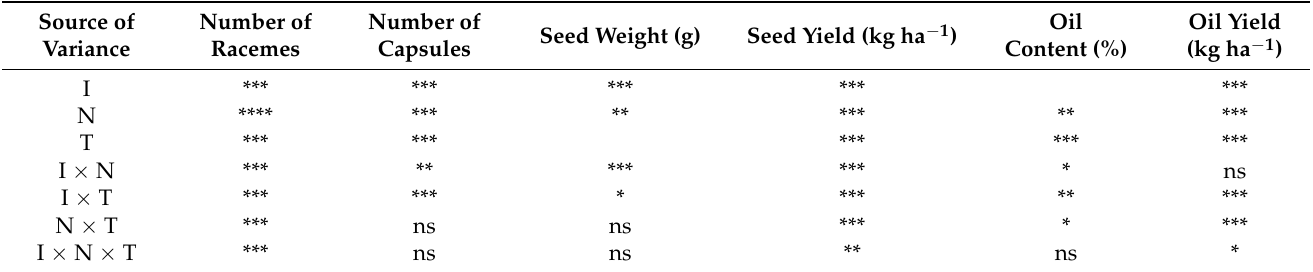
Table 5. ANOVA results of productive traits (I = irrigation, N = fertilization, and T = harvested raceme